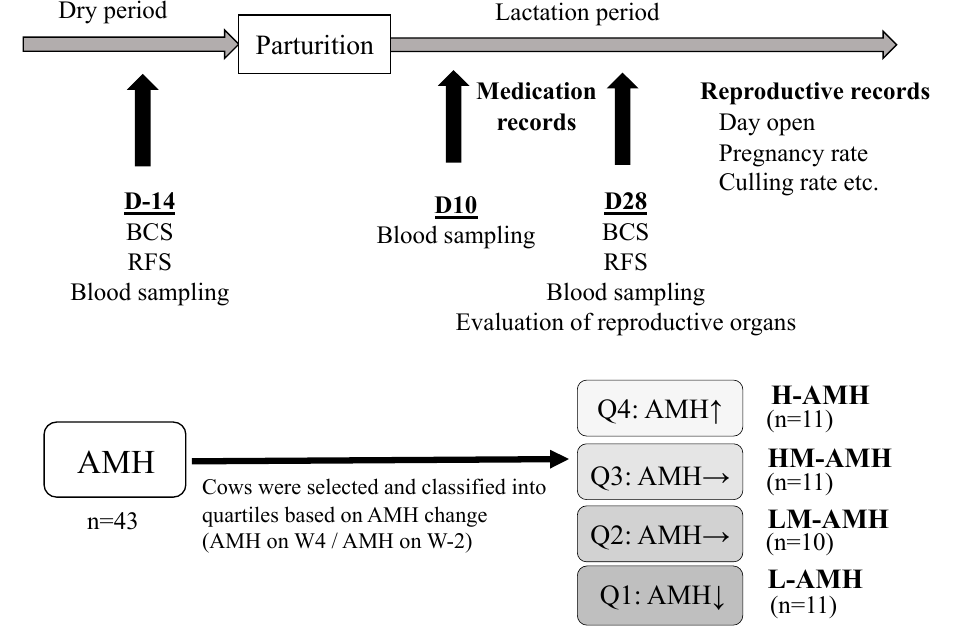
Figure 1. Experimental protocol for samplings and classification/selection of postpartum cows based on the perinatal change of anti-Müllerian hormone (AMH) concentration. BCS: body condition scoring; RFS: rumen fill score; D-14: 14 days before parturition; D10: 10 days after parturition; D28: 28 days after parturition.